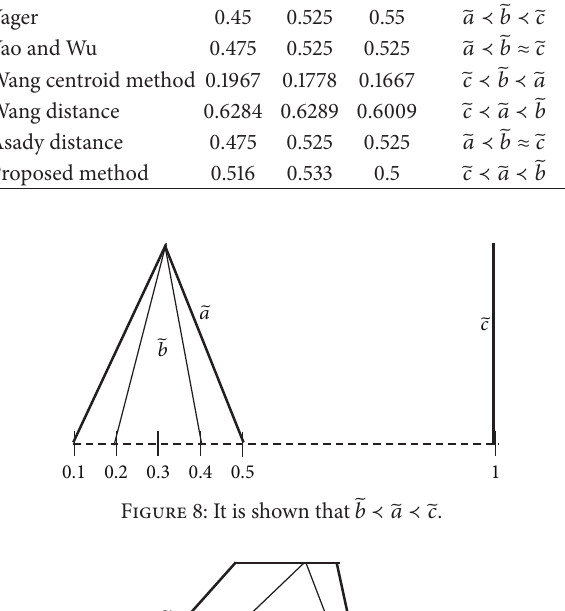
Figure 8: It is shown that